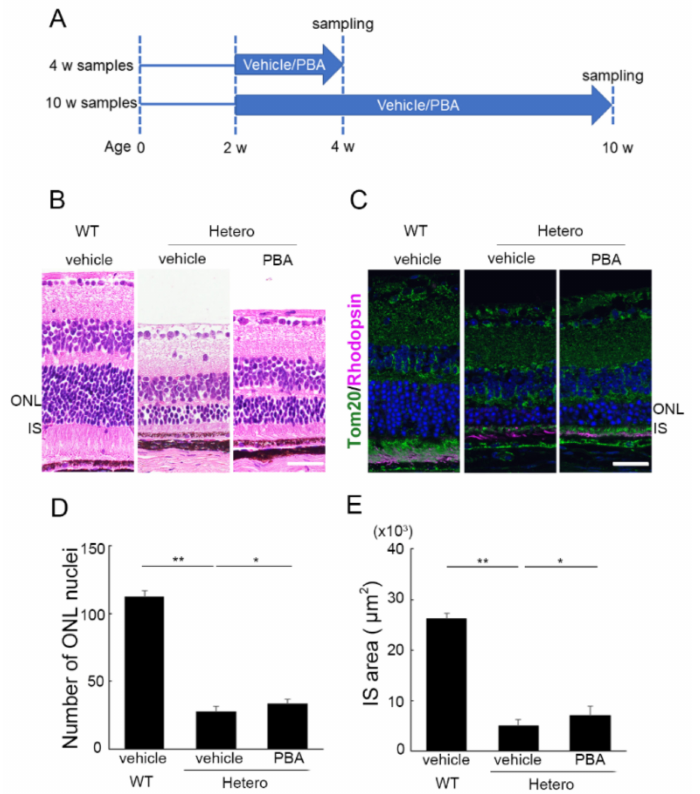
Figure 1. Photoreceptor survival by PBA in the P23H knock-in heterozygotes (P23H RP models) ( A ) P23H knock-in heterozygotes (P23H RP models) started daily treatment with PBA five times a week from 2 weeks of age until the time point of analyses. ( B – E ) Hematoxylin-eosin staining and immunohistochemistry showed that a greater number of photoreceptors ( B – D ) (rhodopsin in pink), and area of IS marked by mitochondria marker, Tom20 (green) ( C , E ) were reduced in the P23H RP models compared with wild-type mice at 10 weeks of age; however, the levels were significantly higher in the models treated with PBA at the same time point. ( D , E ) Data at 200 µ m distance from the optic nerve in the superior retina. RP, retinitis pigmentosa; IS, inner segment. Data are shown as mean ± standard deviation. n for WT treated with vehicle, 3; P23H RP models treated with vehicle, 8–9; P23H treated with PBA, 8. ONL, outer nuclear layer; IS, inner segments. * p < 0.05, ** p < 0.01. Scale bar, 20 µ